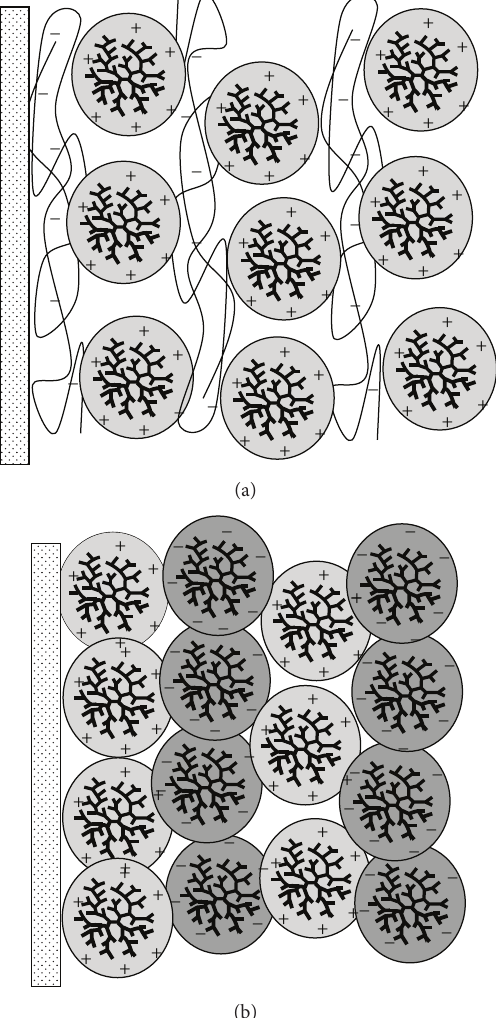
Figure 8: Example of polymer/dendrimer (a) and dendrimer/ dendrimer (b) layer-by-layer (LbL)